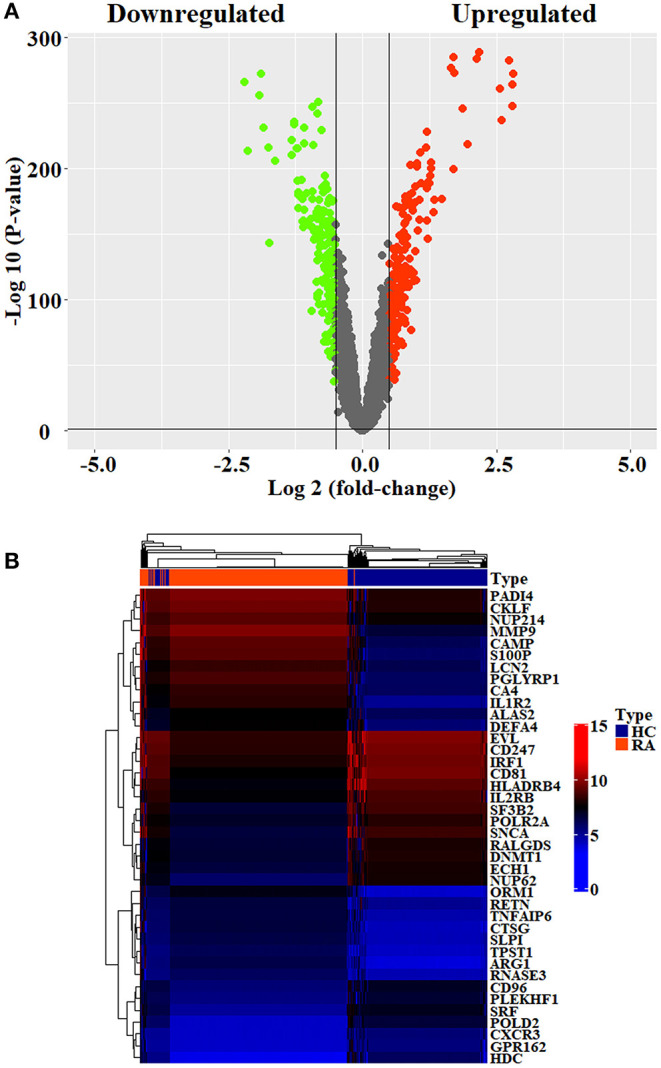
Differential analysis of datasets. (A) Volcano plots showing the differentially expressed genes screened by the criteria of |log2FC| >1 and p < 0.05. The upregulated and downregulated genes were denoted by red spots and green spots, respectively. (B) The top 10 DEGs with the smallest p-values in the upregulated and downregulated clusters were taken out, respectively, to generate heatmap.